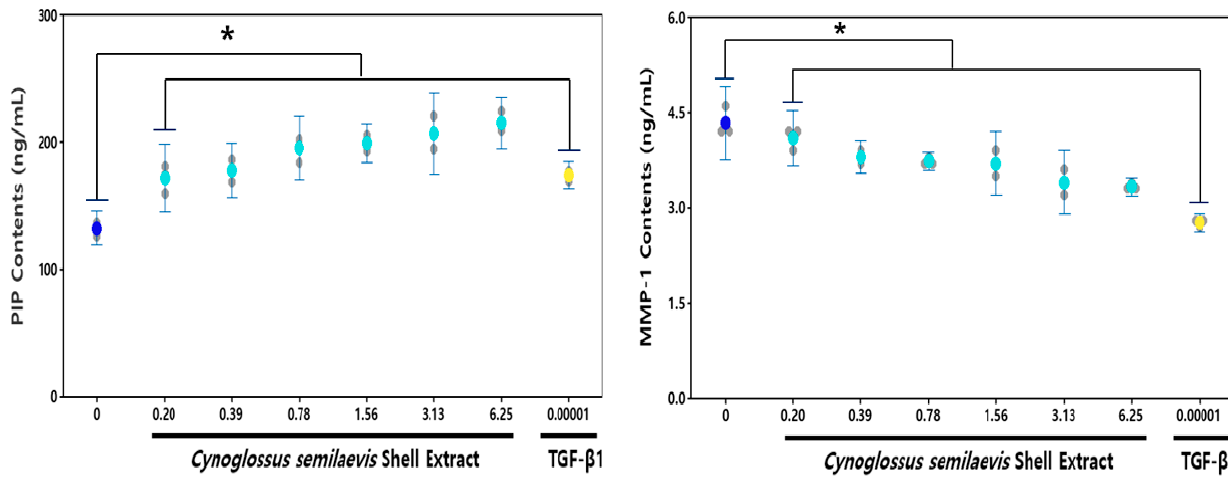
Figure 3. Effect of CSE on the cellular release of type I α 1 pro-collagen ( A) and MMP-1 ( B ) in HDFs. The contents of type I α 1 pro-collagen and MMP-1 were calculated from HDF culture media following 24 h incubation with different concentrations of CSE using ELISA. The data are expressed as % of Solvent control (Mean ± SD ( n = 3). * p < 0.05, Cynoglossus semilaevis shell extract vs. Solvent